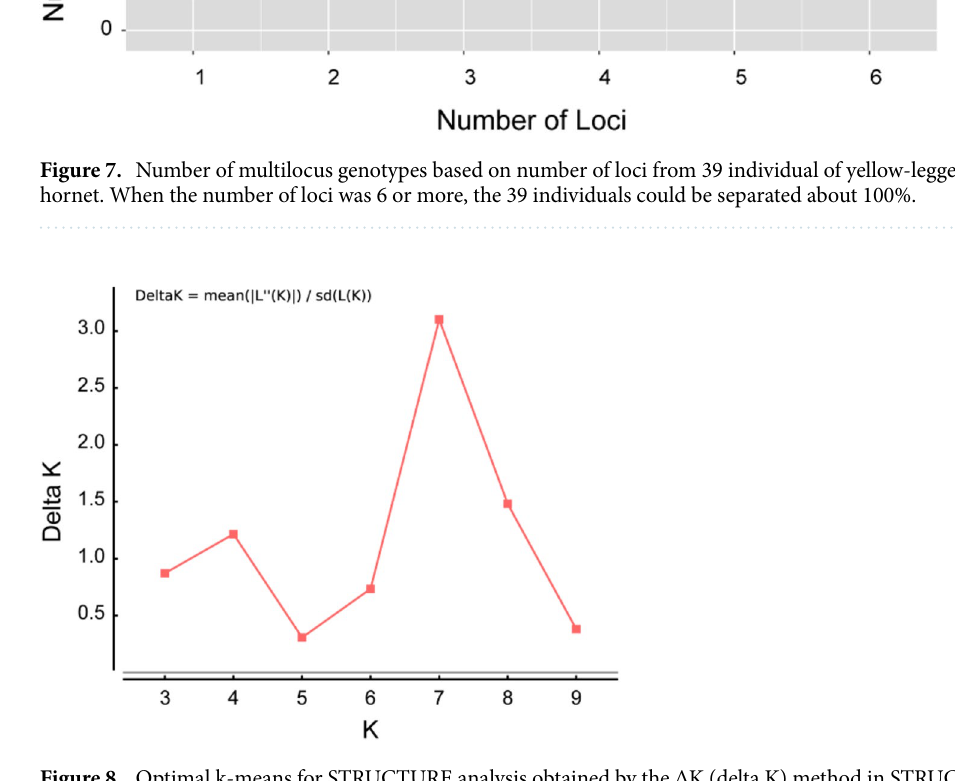
Figure 8. Optimal k-means for STRU CTU RE analysis obtained by the ΔK (delta K) method in STRU CTU RE harvest. Here, 100,000 simulations after burn-in of 100,000 simulations were used to obtain the three independent runs for range of 2 to 14 possible clusters. The highest delta K value was 7